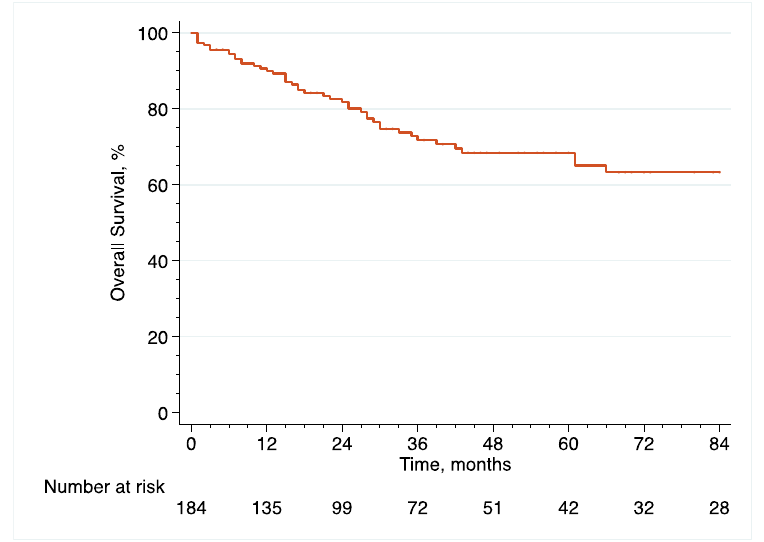
Figure 3. Kaplan–Meier curve that analyses the OS of included patients treated with eRC for HR-NMIBC.